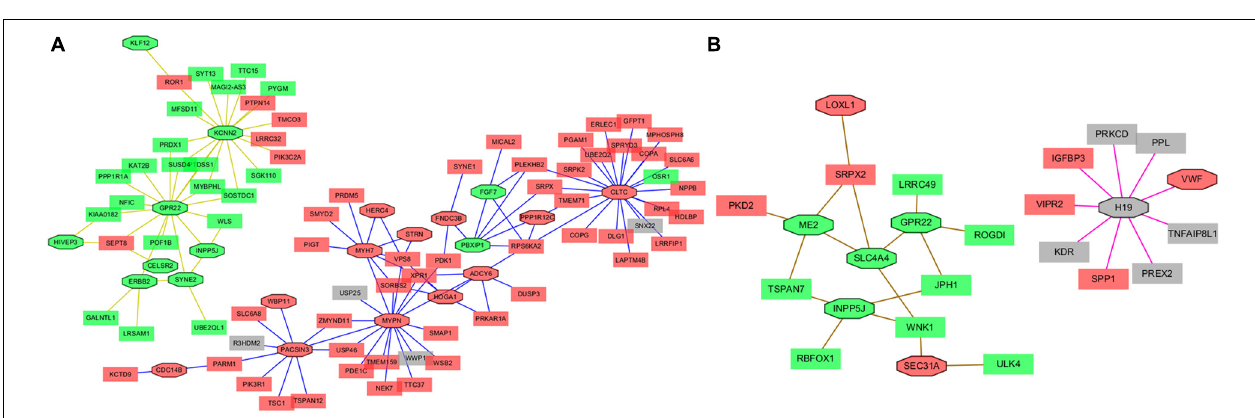
FIGURE 7 | The Network view from Cytoscape. (A) The Network view from Cytoscape in LAA. (B) Network view from Cytoscape in RAA. The module edge > 0.15. Green color represents downregulated genes with GS > 2, red color represents upregulated genes with GS > 2, and gray color represents the genes with GS < 2. Octagon nodes represent core genes. GS, gene significance; LAA, left atrial appendage; RAA, right atrial